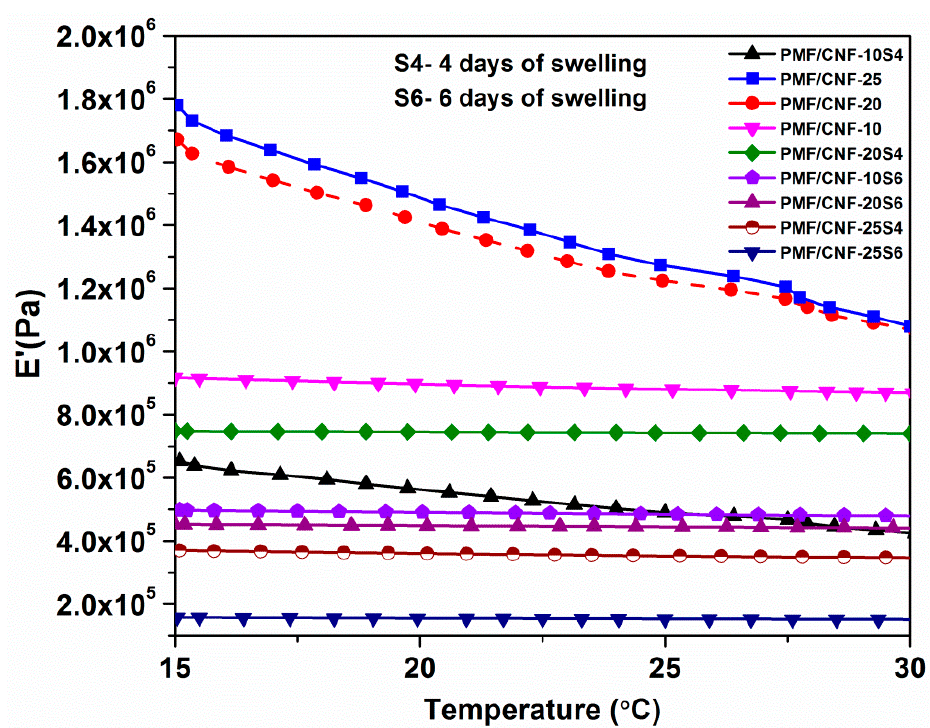
Figure 7. Tensile storage modulus (E’) of dry and wet films of PMF/CNFs composites as a function of CNFs content. Table 1. Dynamic mechanical properties of dry and water swollen films of PMF/CNFs composites at 25 °C.